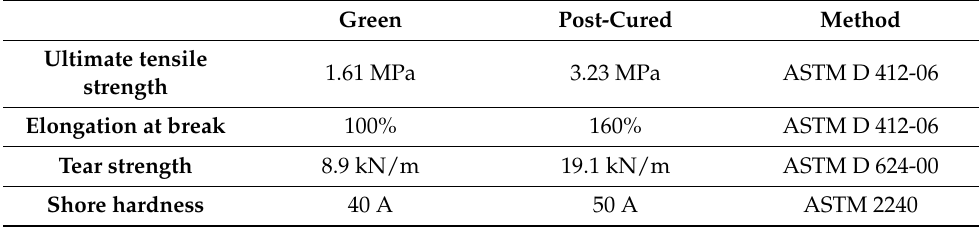
Table 3. Mechanical properties of the employed “Elastic resin”, as declared by the producer. Source: Formlabs Materials